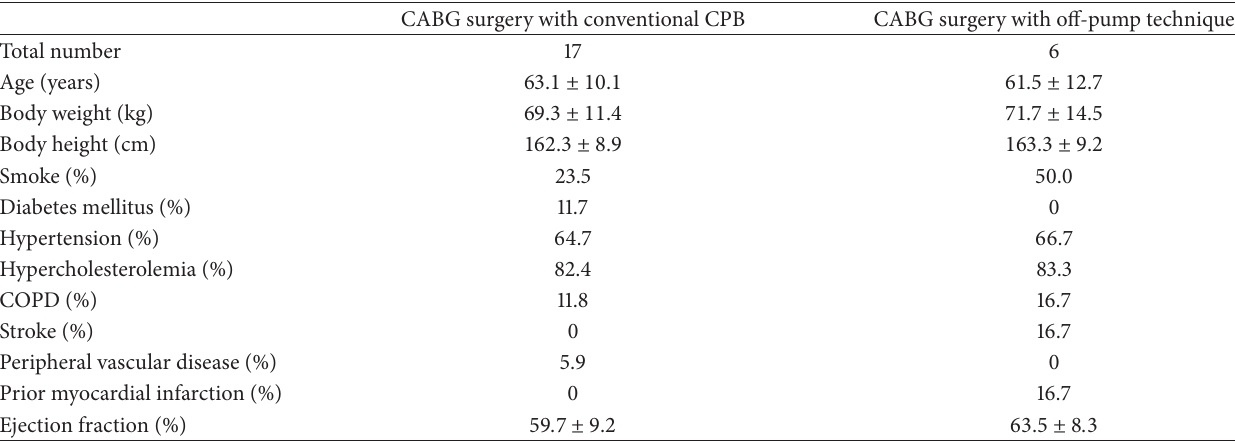
Table 1: Preoperative characteristics in CABG surgery patients.